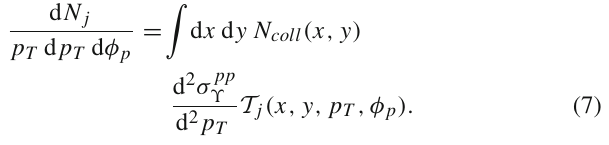
Fig. 2 Transverse momentum dependence of nuclear modification factor R AA ( p T ) for ϒ( 1 S ) state for Pb + Pb collisions at 5 . 02 TeV in 0–90% centrality class for ALICE and 0–100% centrality class for model calculation and CMS. The model calculations and the CMS measurements are at mid-rapidity and the ALICE measurements are at forward rapidity (2 . 5 < y < 4 . 0). For ALICE and CMS data points the statistical and systematic errors are added in quadrature